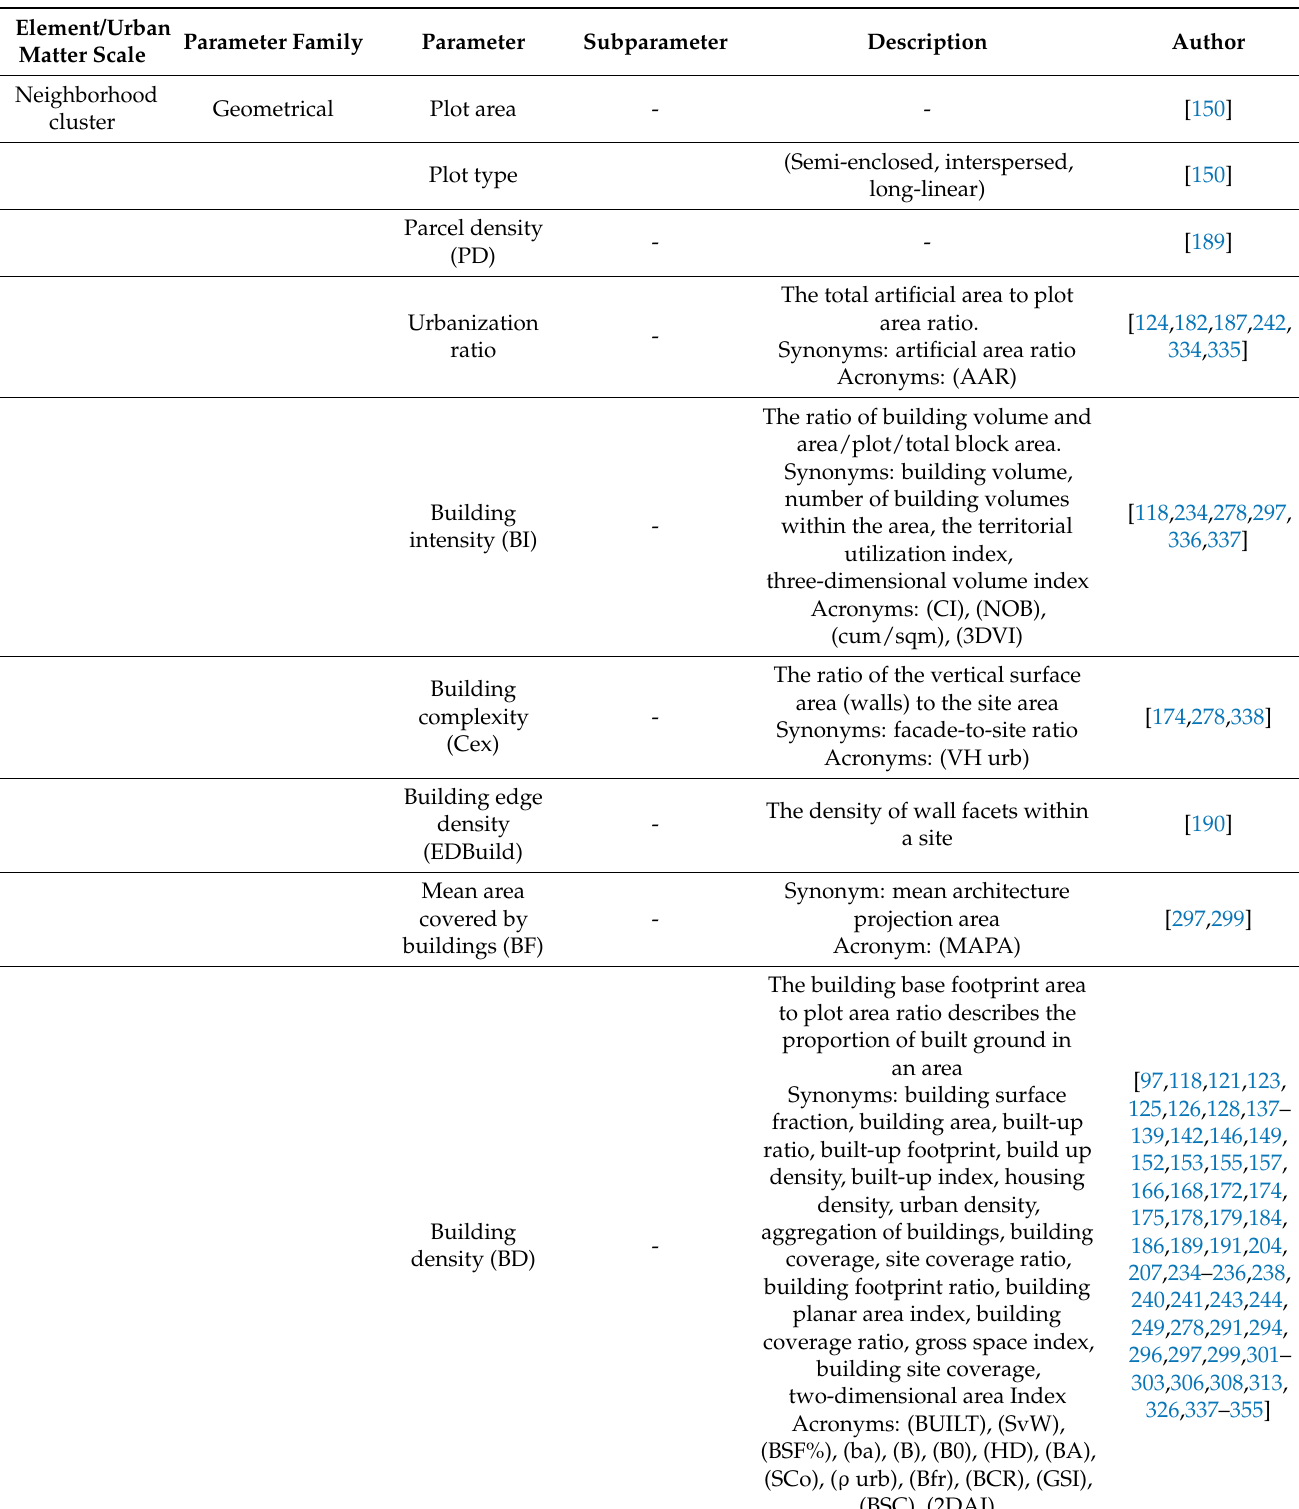
Table A1. Designing parameters of the urbanized elements (UE) elements affecting the urban heat island (UHI) propagation in warm temperate climate